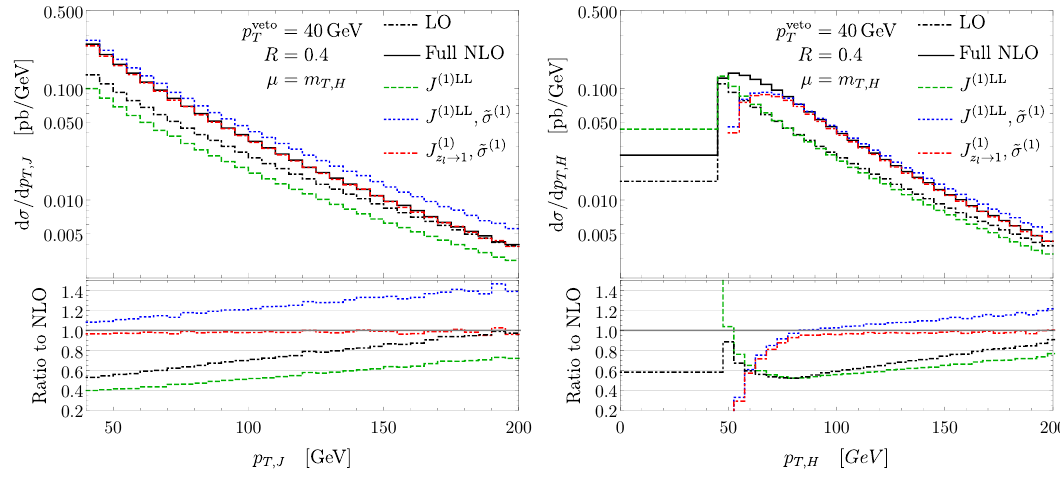
Figure 5 . The p T;J (left) and p T;H (right) distributions in exclusive Higgs + 1 jet production at LO (dot-dashed black) and NLO (solid black) with R = 0 : 4 and (cid:22) = m T;H . Also shown are predictions from the singular cross section using the LL (blue dashed) and soft (red dot-dashed) approximations of the jet functions, as well as the LO cross section augmented only with the (cid:11) s ln R terms (green